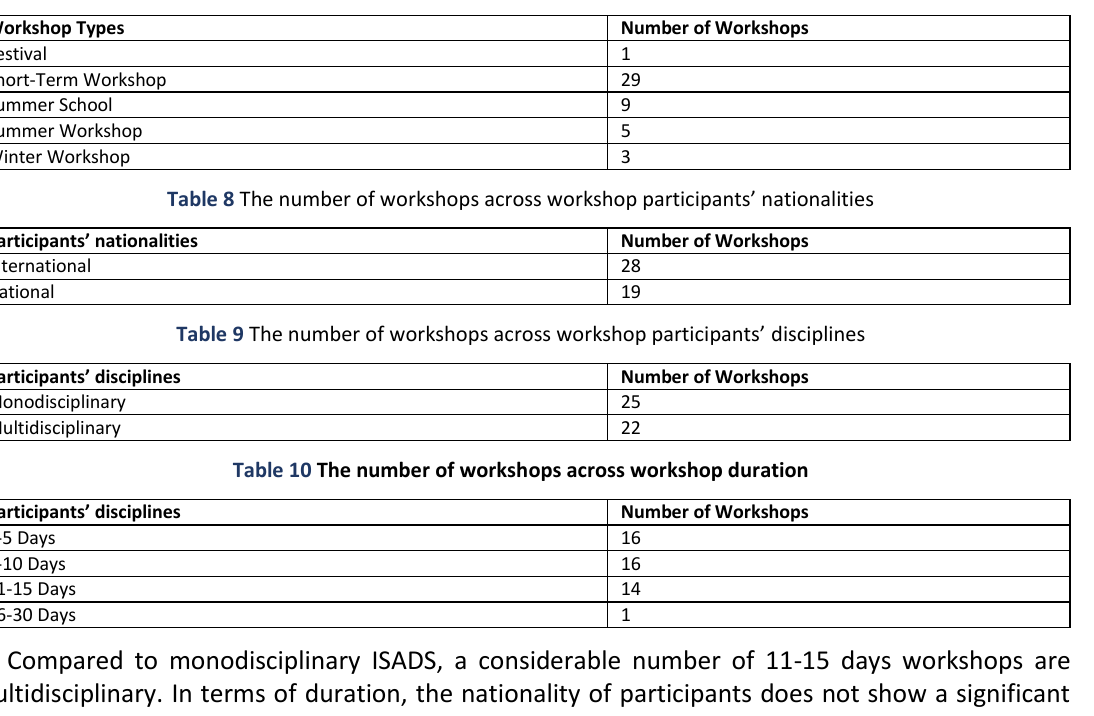
Table 7 The number of workshops across workshop type